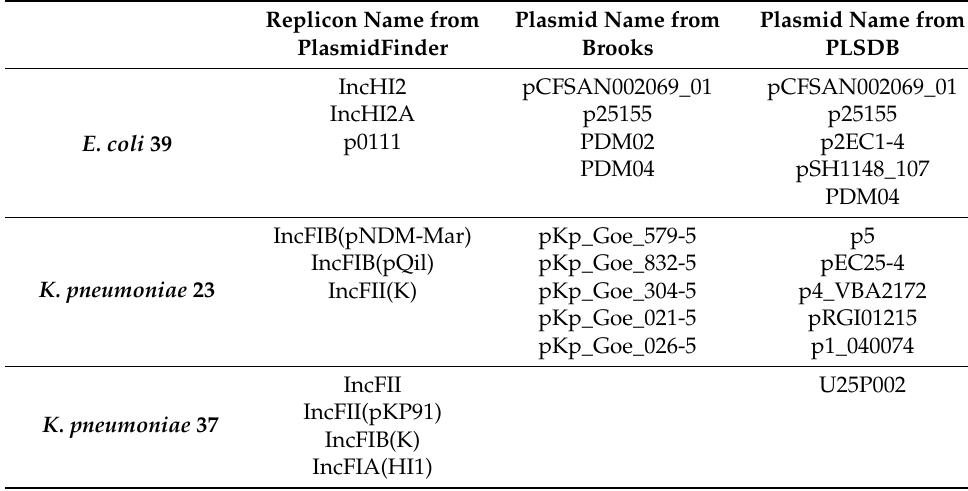
Table 4. An overview of the first top-five putative plasmids (P TRUE ) in hybrid assembled E. coli and K. pneumoniae isolates retrieved from the different